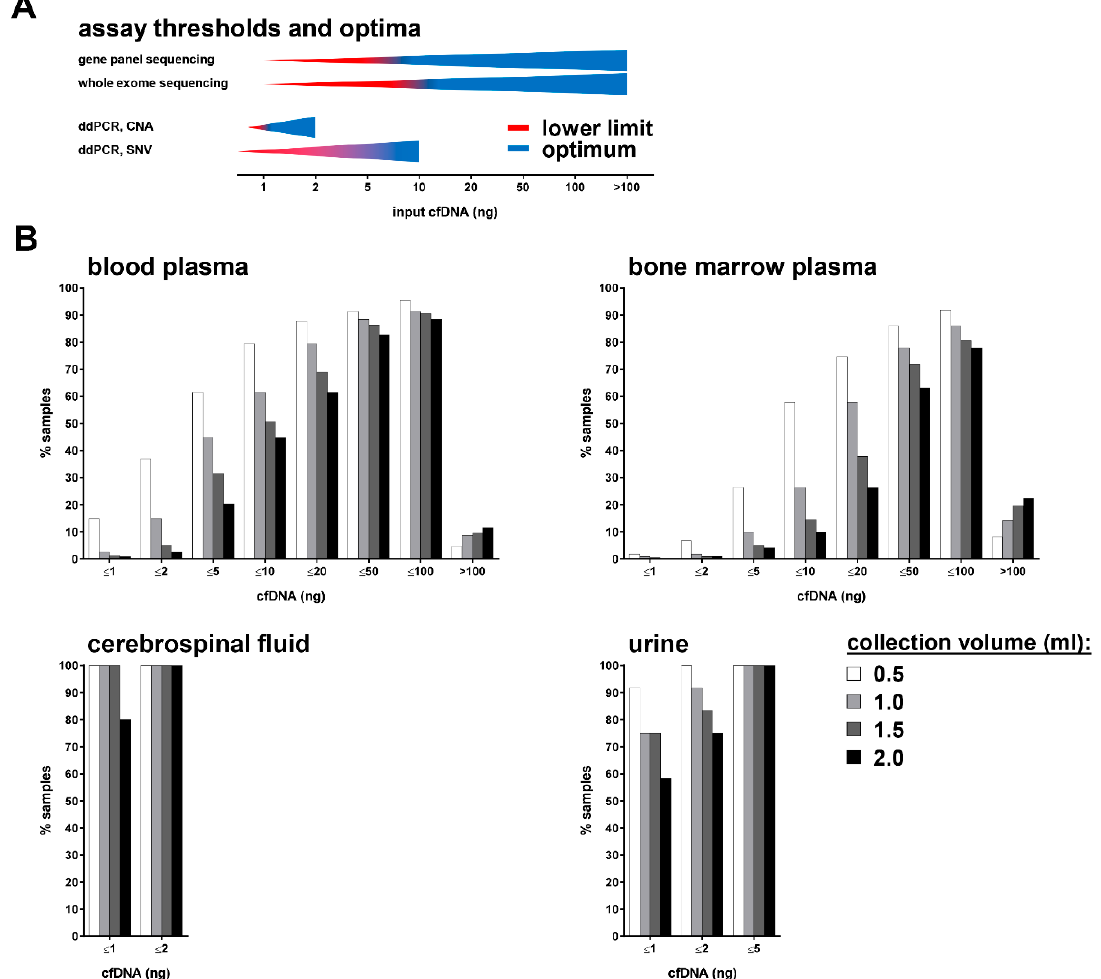
Figure 4. Comparison of cell-free DNA availability with minimum and optimum input requirements for cfDNA analysis. ( A ) Schematic diagram summarizing the sample requirements of selected sequencing and PCR technologies [16,41–43]. ( B ) Percentage of samples fulfilling the DNA input thresholds as indicated. CNA, copy number alteration; SNV, single nucleotide variation.